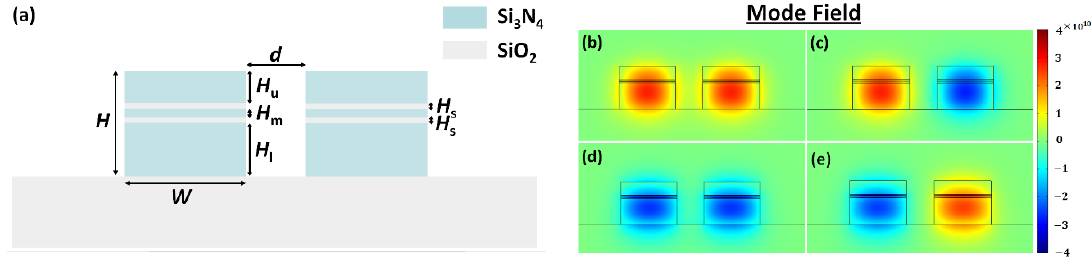
Figure 10. Schematic cross section ( a ) and the electric field distributions ( b – e ) of the multi-slot Si 3 N 4 -based waveguide PBS.